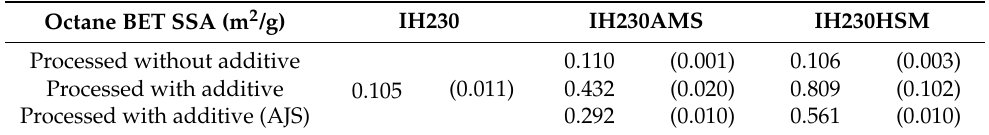
Table 2. SSA of the raw material and that processed with and without the additive. Data marked with “AJS” display results after removal of residual particles via air-jet sieving n = 3, SD in parentheses. Octane BET SSA (m 2 /g) Processed without